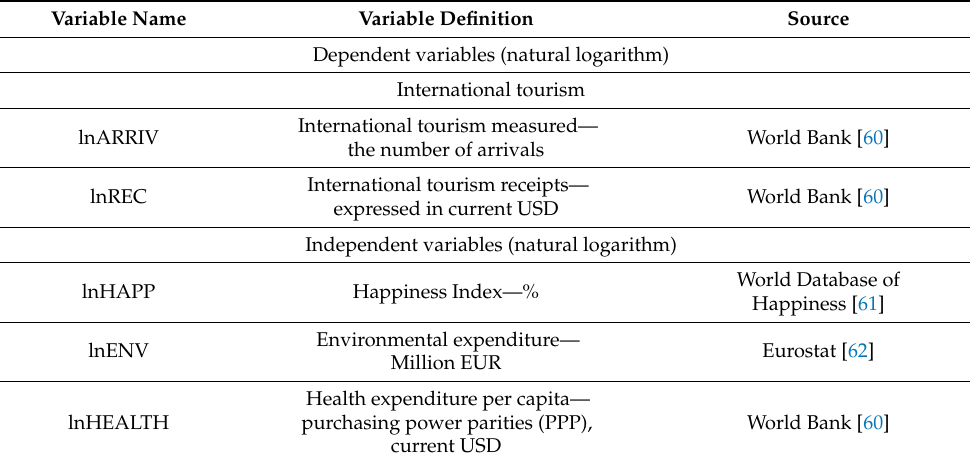
Table 1. Definition of variables and data sources.